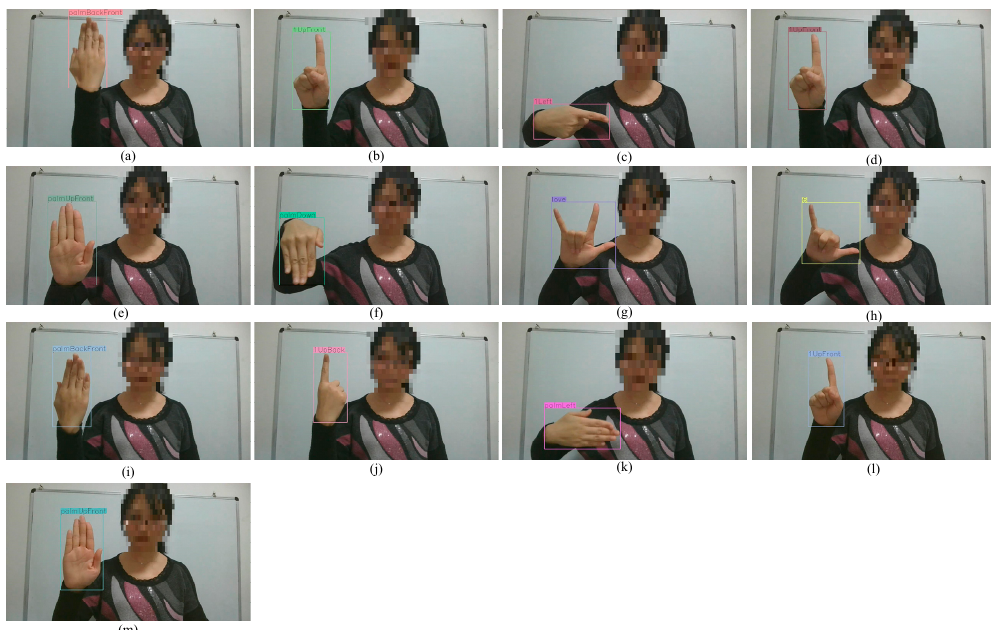
Figure 15. Example of comparison when the system correctly classifies the hand posture and when it fails. ( a ) The hand posture is incorrectly classified; ( b ) the hand posture is correctly classified.